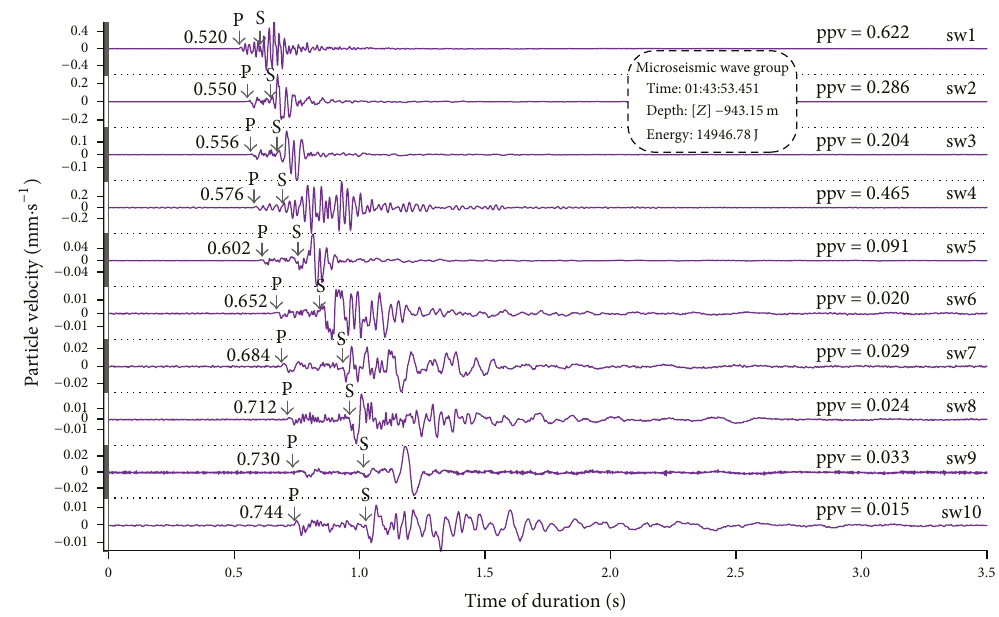
Figure 4: Original waveform of a microseismic event obtained in the field investigation.